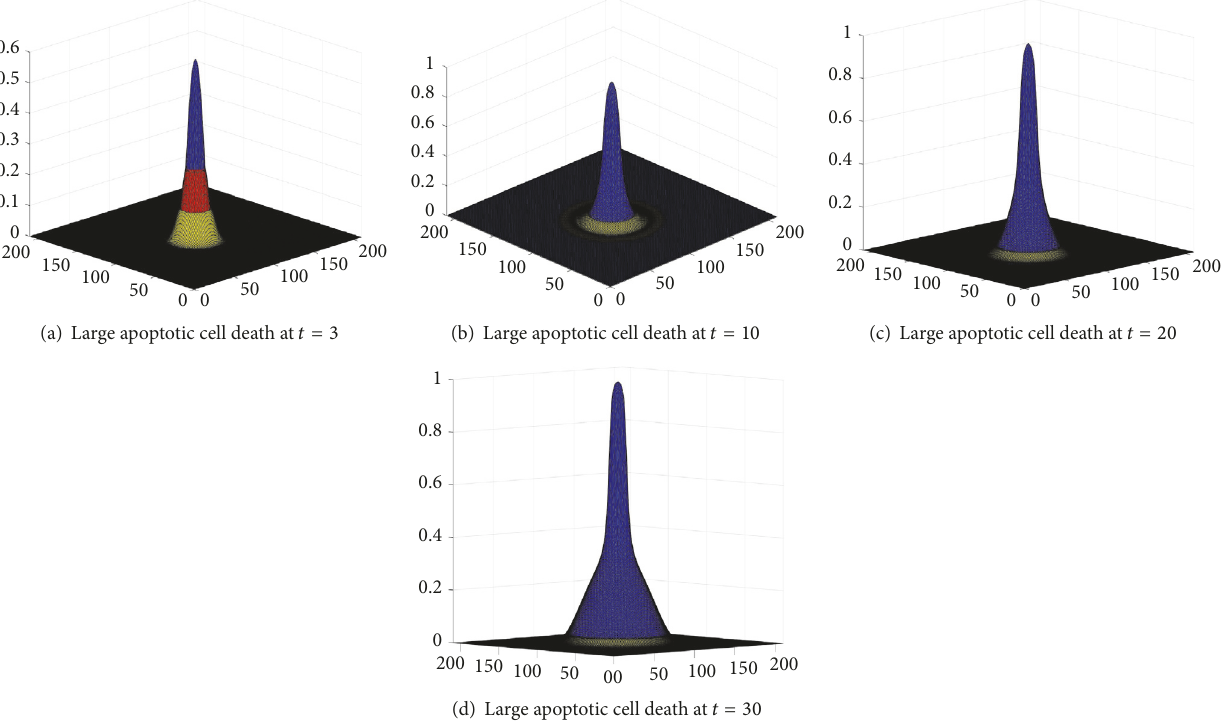
Figure 11: Large apoptotic cell death ( 𝑘 𝑁 = 0.1 ) at different